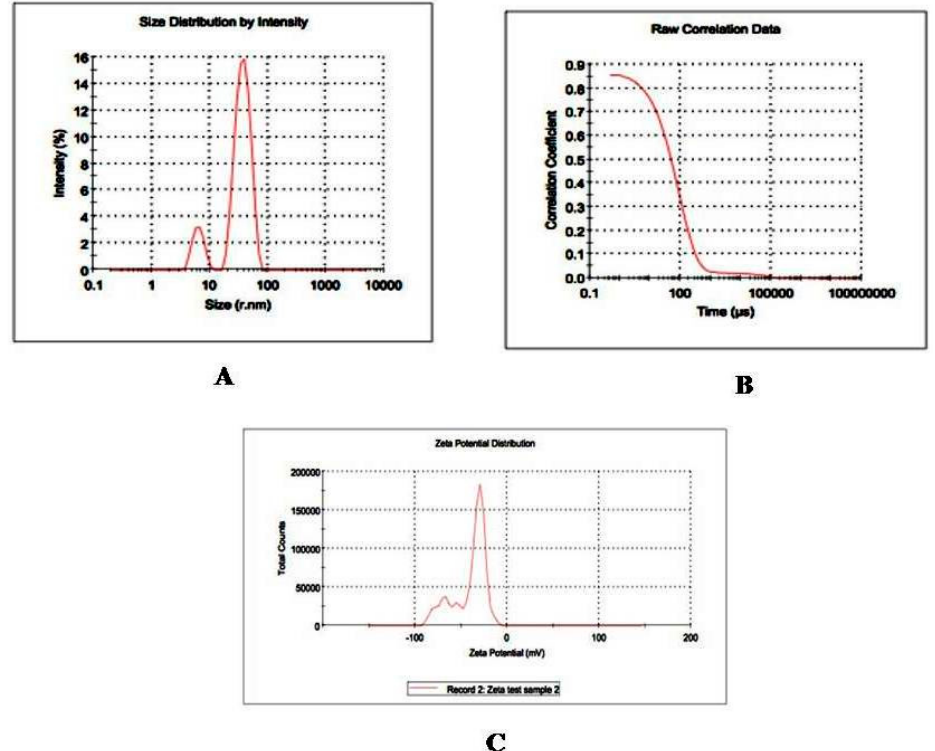
Figure 1. Nanostructure size and zeta potential were measured in deionized water (DI water) using a Nano Zetasizer ( A ) GOs size by Dynamic Light Scattering (DLS) intensity, ( B ) Raw correlation data; ( C ) Zeta